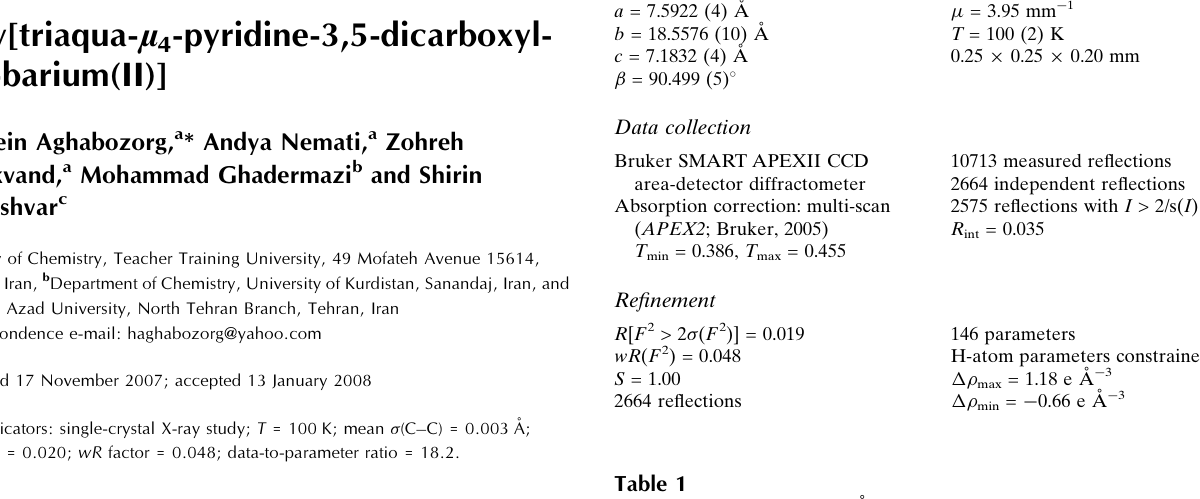
Hydrogen-bond geometry (A˚ , (cid:3)